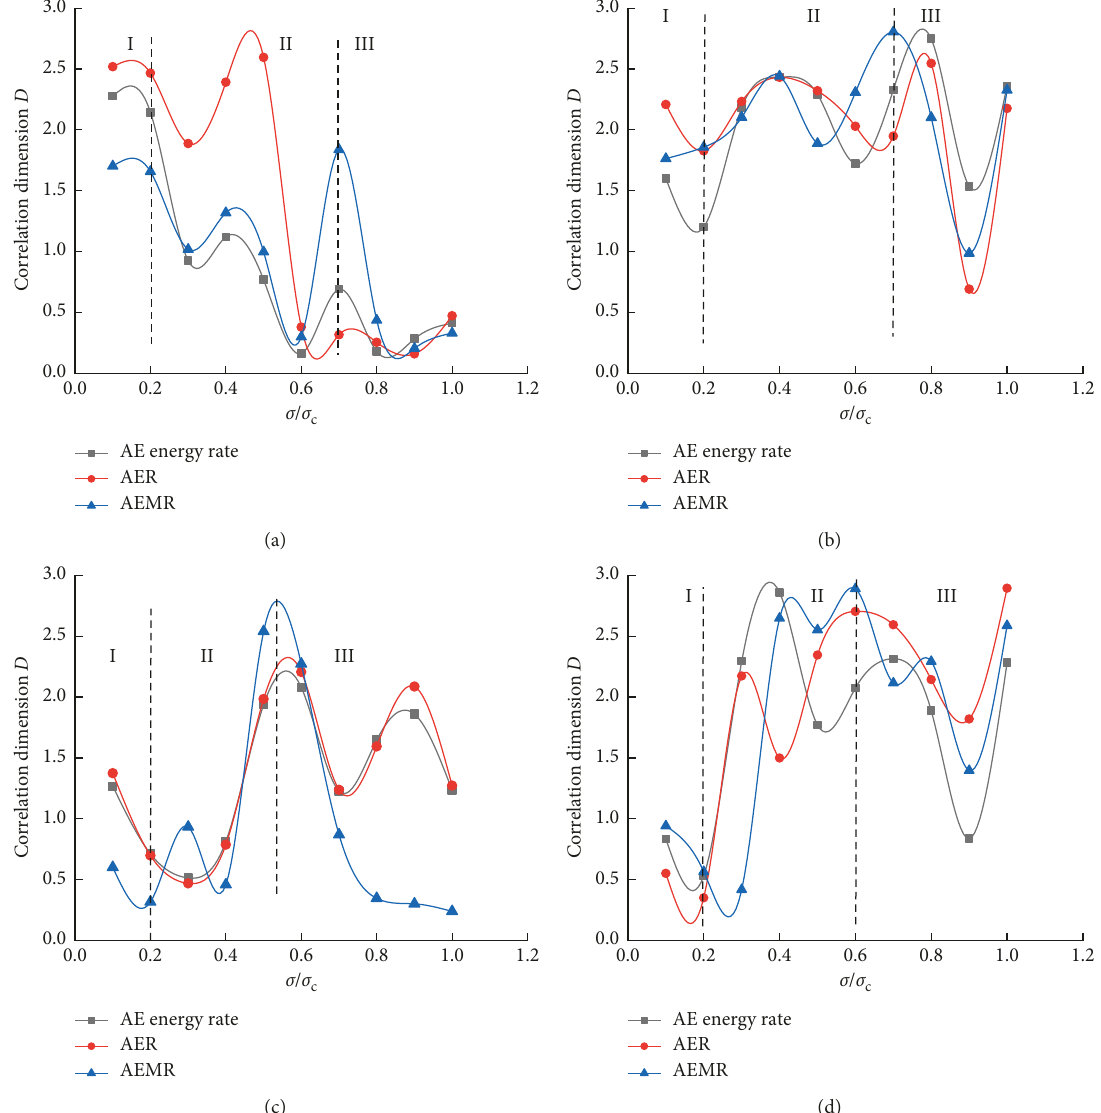
Figure 8: Changes of fractal dimension of specimens with different body types. (a) Cubic red sandstone. (b) Cylindrical red sandstone. (c) Cubic granite. (d) Cylindrical